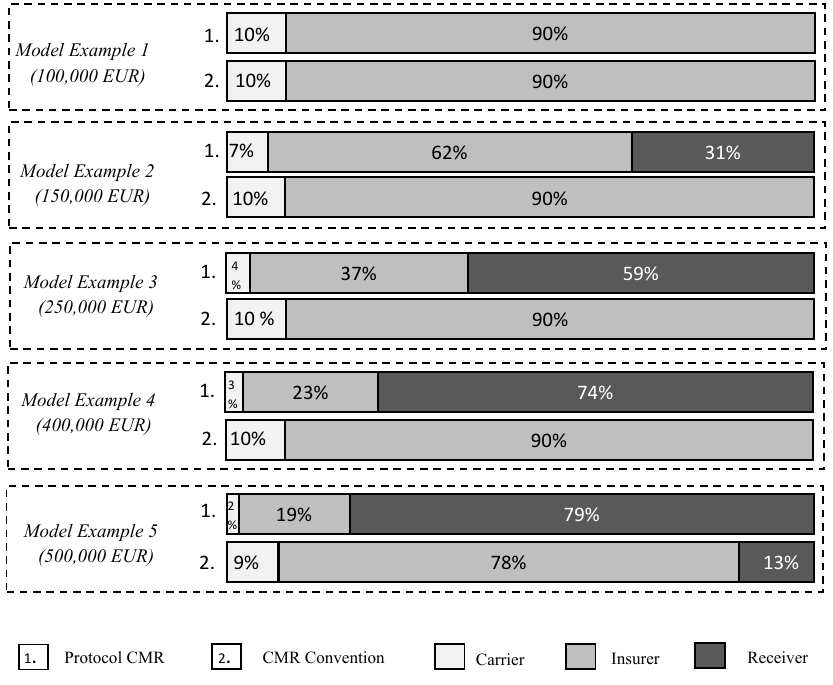
Fig. 1 – Share of the carrier’s liability, the insurer and the receiver on the damaged goods. Source: own